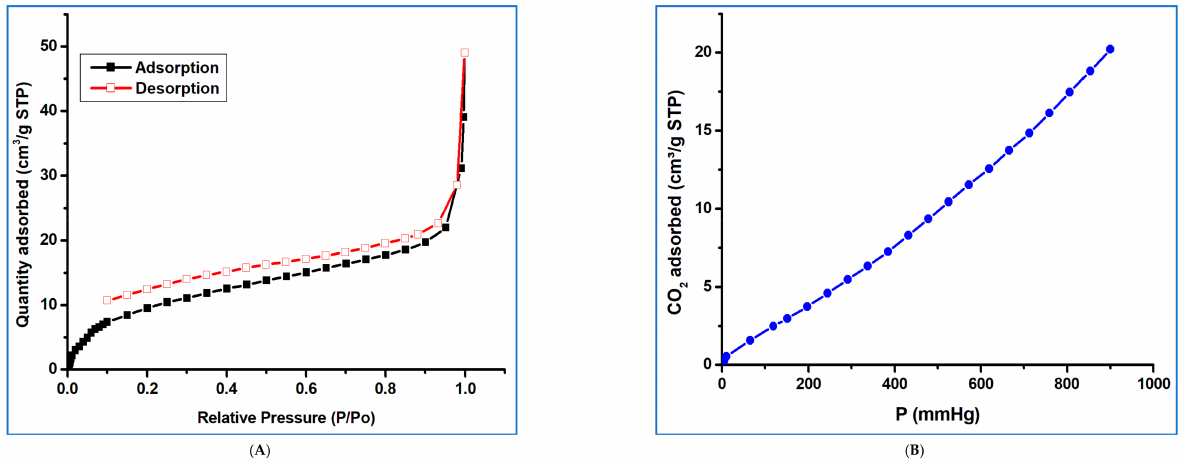
Figure 1. ( A ) N 2 sorption isotherm of framework 1 at 77 K. ( B ) CO 2 sorption isotherm of 1 at 273